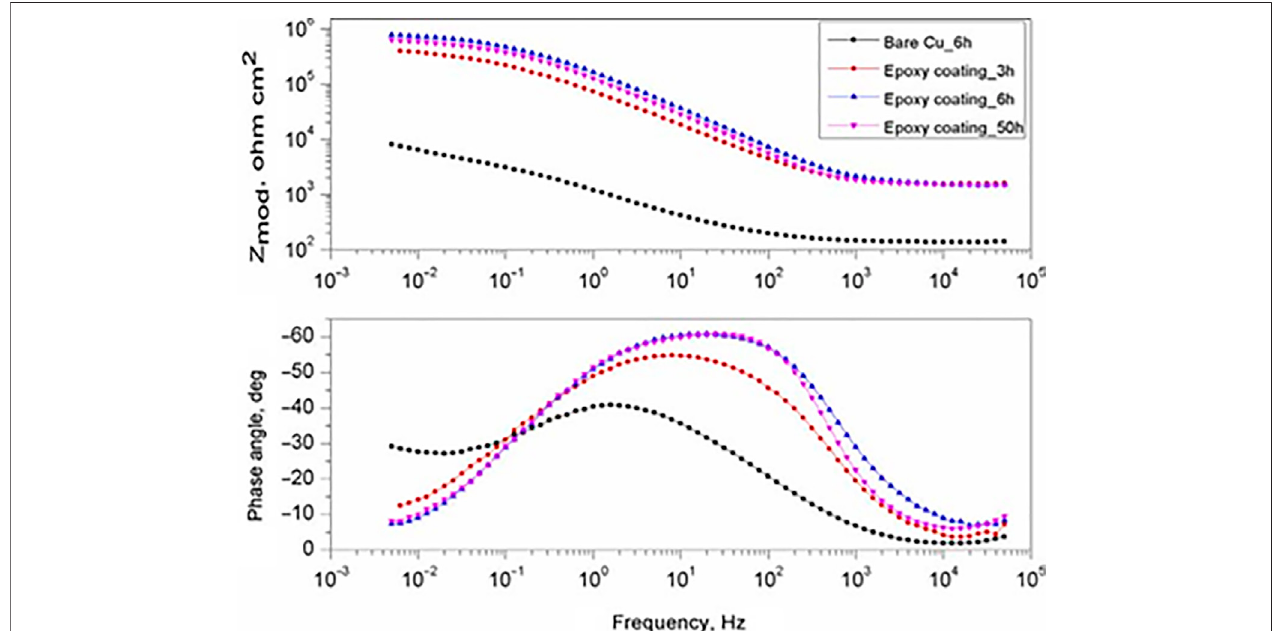
FIGURE 8 | EIS Bode plots for ORMOSIL-TiO 2 (8-HQ) after 3, 6, and 50 h in 0.05 M NaCl together with bare Cu.